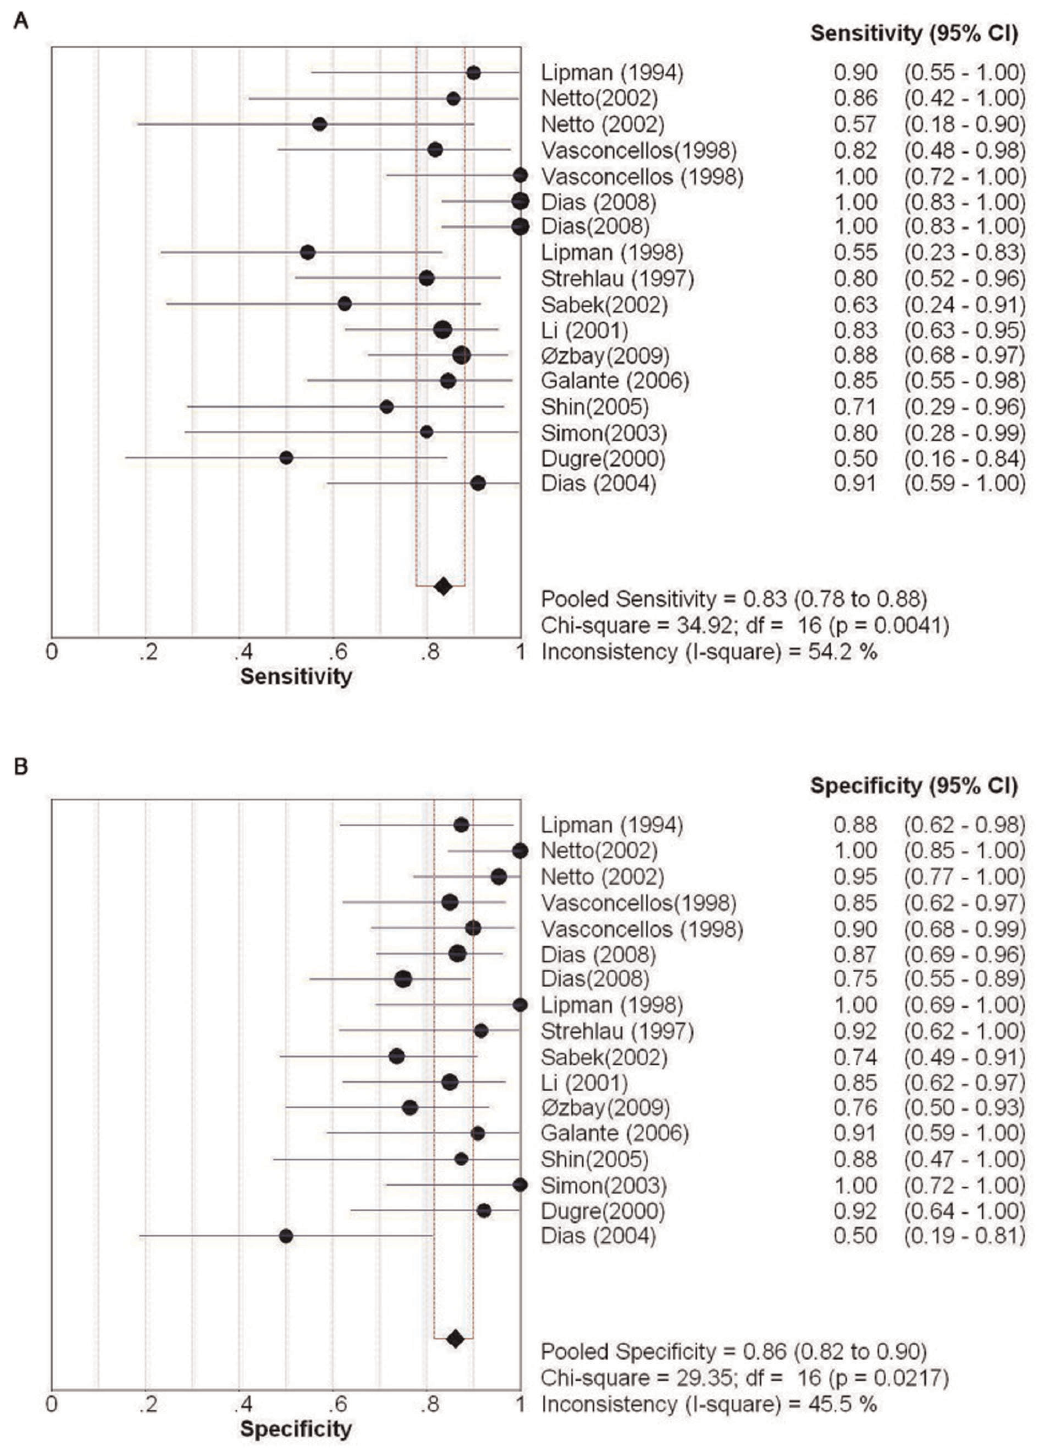
Figure 2. Sensitivity and specificity of perforin mRNA detection for the diagnosis of AR. (A) Pooled sensitivity. (B) Pooled specificity. Effect sizes were pooled by random-effects models. The point estimates from each study are shown as solid squares. The pooled estimates are shown as a solid diamond. Error bars represent 95% CIs. doi:10.1371/journal.pone.0039610.g002 the limited number of data sets using each perforin sequence restricted us from categorizing the studies into subgroups for the univariate analysis.